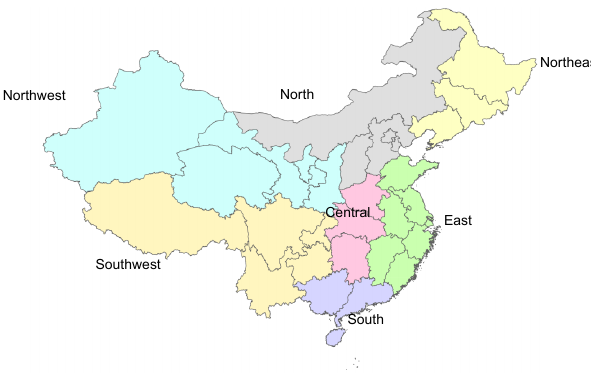
Figure 1. Seven regions in China used for analysis in this